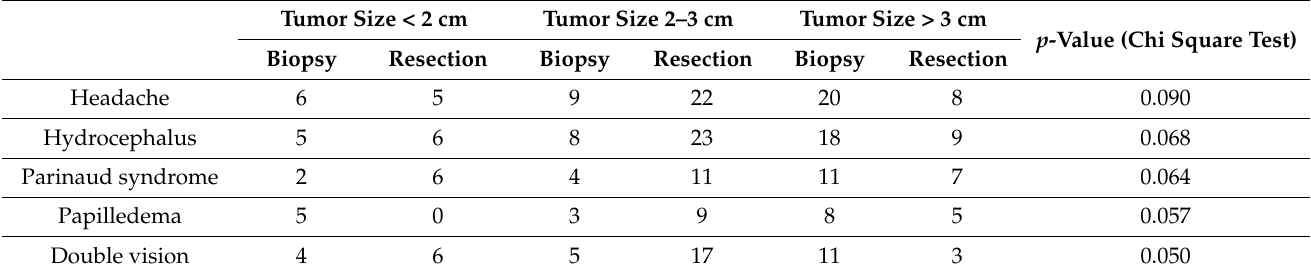
Table 2. Relationship between tumor size and primary symptoms. No significant relationship was found between primary symptoms and tumor